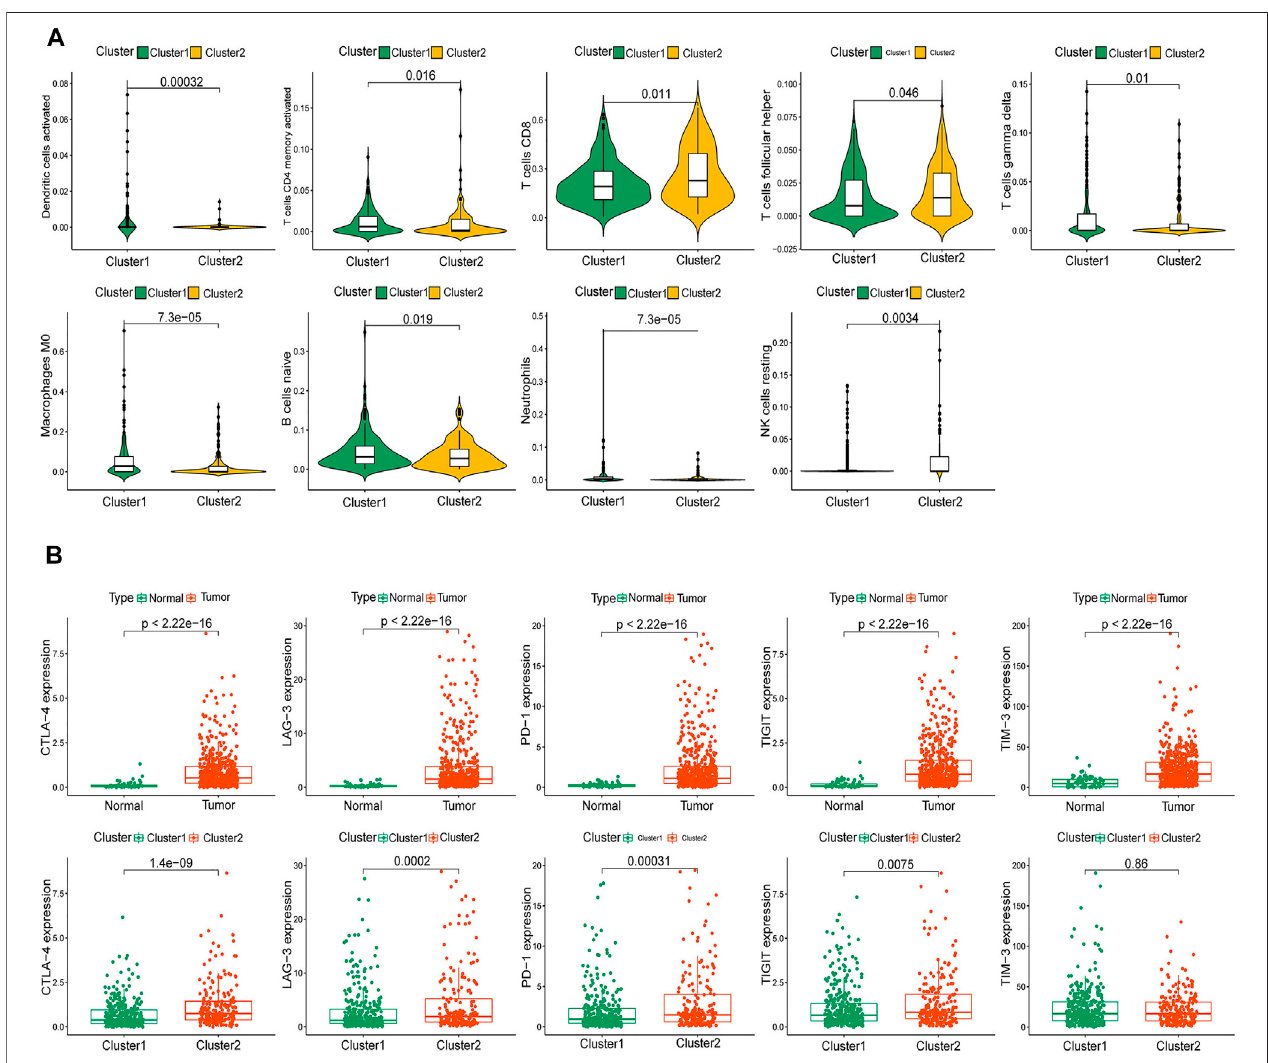
FIGURE4| Immunestatusofpatientsinthetwoclusters. (A) Identi fi cationofninetypesoftumor-in fi ltratingimmunecells(TICs)inthetwoclusterswith p < 0.05. (B) Distribution of fi ve immune checkpoints.